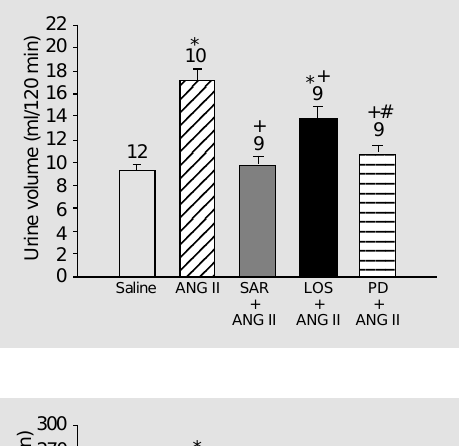
Figure 6. Effect of pretreatment with [Sar 1 , Ala 8 ] ANG II (SAR, 40 nmol), losartan (LOS, 40 nmol), and PD 123319 (PD, 40 nmol) into the paraventricular nucleus on sodium excretion induced by injection of ANG II (10 nmol) into the medial septal area. Data are reported as means ± SEM. The number of animals is indicated at the top of each column. * P<0.05 compared with saline (control); + P<0.05 compared with ANG II; # P<0.05 compared with losartan Figure 7. Effect of pretreatment with [Sar 1 , Ala 8 ] ANG II (SAR, 40 nmol), losartan (LOS, 40 nmol), and PD 123319 (PD, 40 nmol) into the paraventricular nucleus on mean arterial blood pressure (MAP) changes induced by in- jection of ANG II (10 nmol) into the medial septal area. Data are reported as means ± SEM. The number of animals is indicated at the top of each column. * P<0.05 compared with saline (control); + P<0.05 compared with ANG II; # P<0.05 compared with losartan (ANOVA).